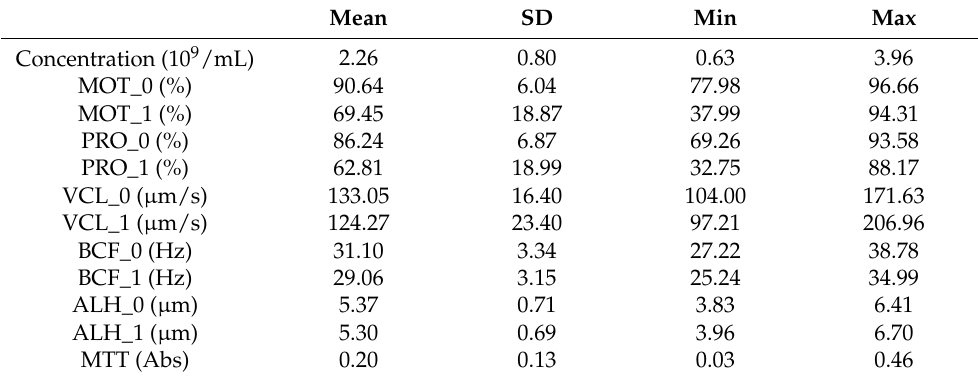
Table 2. Bull sperm quality parameters.